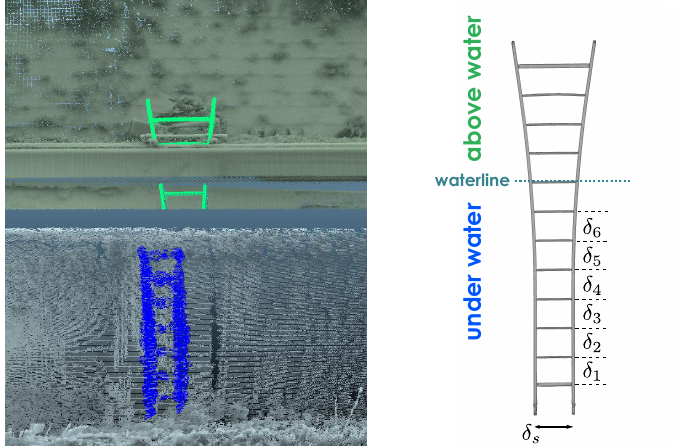
Figure 14. ( Left ) Segmentation of a ladder in the TLS model ( Top , in green) and in the MSS model ( Bottom , in blue). The upper part of the ladder is partly masked because it was placed behind a boom, ( Right ) Reference TLS survey of the ladder.